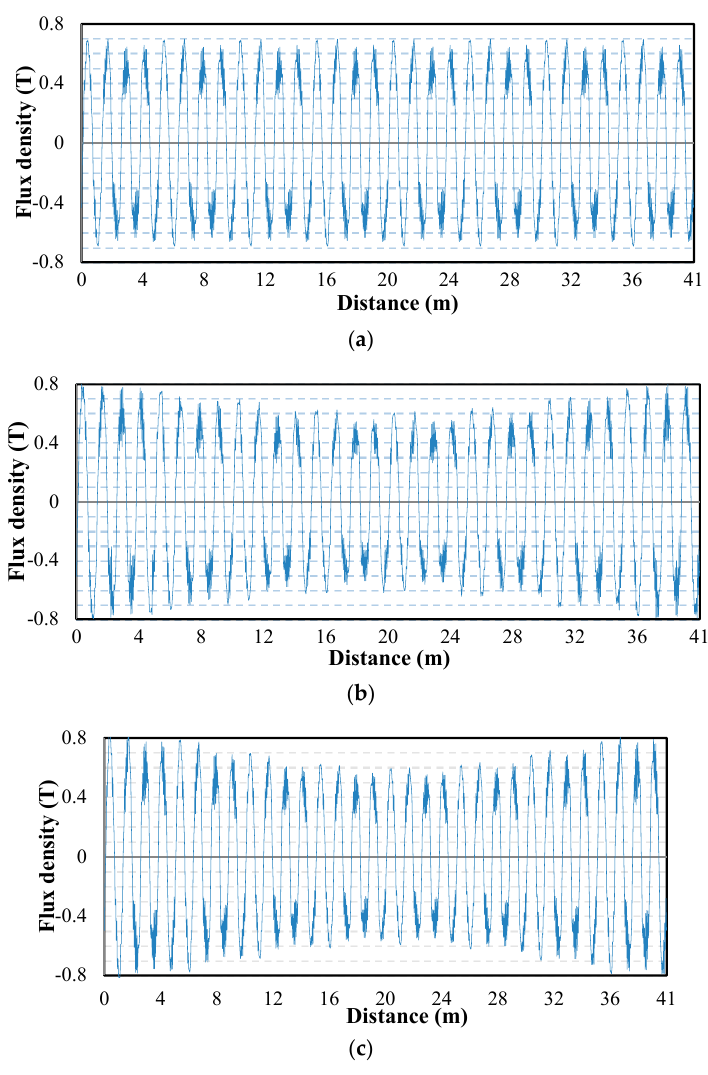
Figure 12. Magnetic flux density at the center of air-gap with different eccentric models: ( a ) concentric model; ( b ) static eccentric model; and ( c ) dynamic eccentric